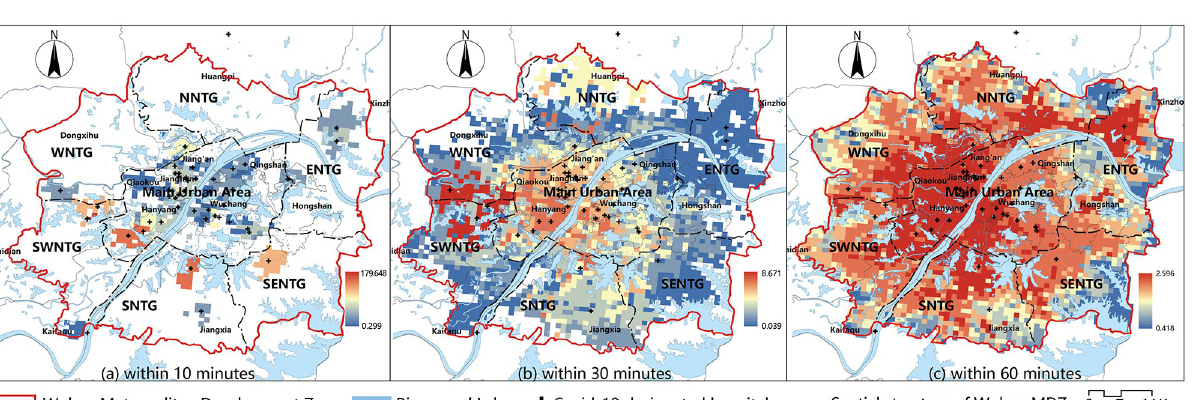
PLOS ONE | https://doi.org/10.1371/journal.pone.0272458 August 2,